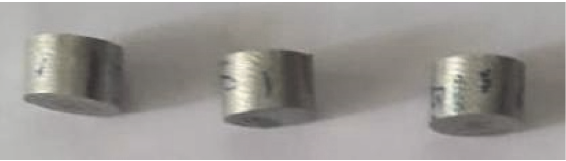
Figure 8: Hardness test